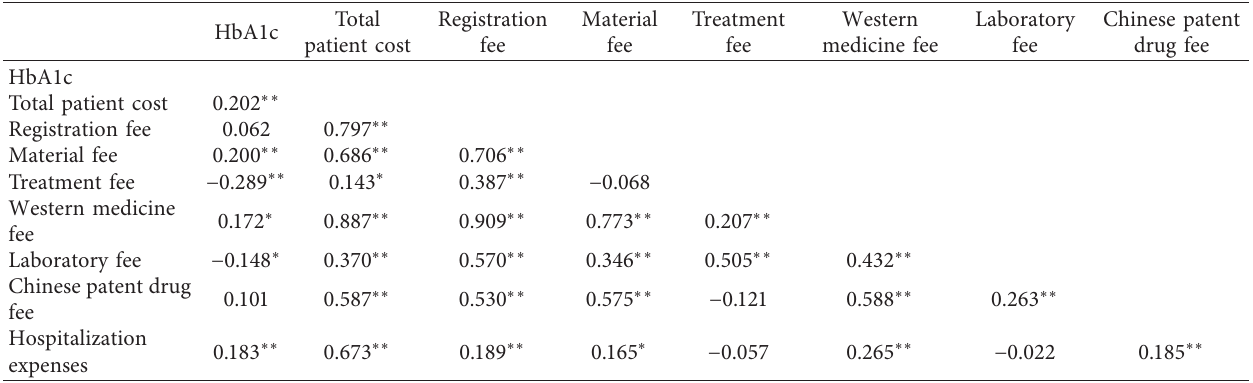
Table 2: Correlation between HbA1c and cost ( r ).